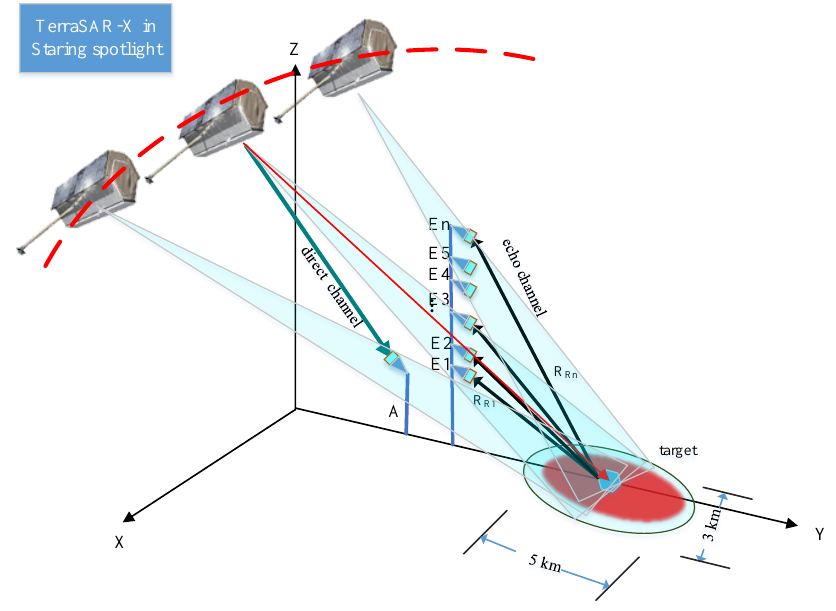
Figure 1. Multichannel BiSAR System with TerraSAR-X in staring spotlight